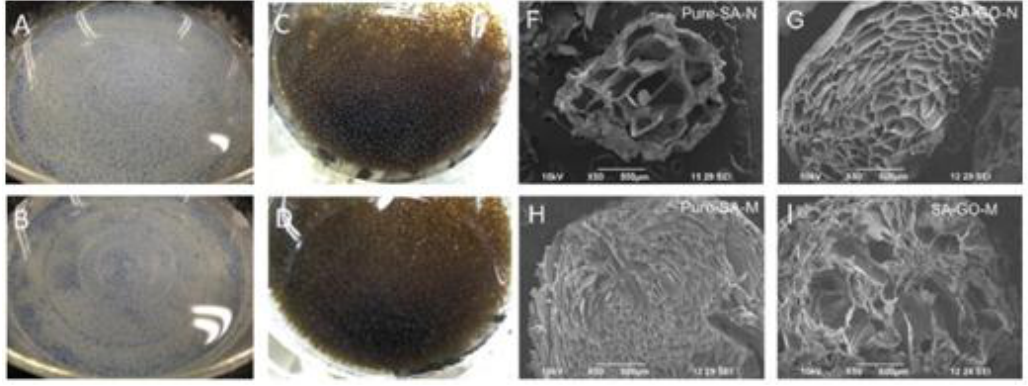
Figure 2. Photographic and SEM images of Pure SA beads ( A , F ); SA/GO beads ( C , G ); SA/CaCO 3 beads ( B , H ); and SA/GO/CaCO 3 beads ( D , I ). Reprinted with permission by Elsevier